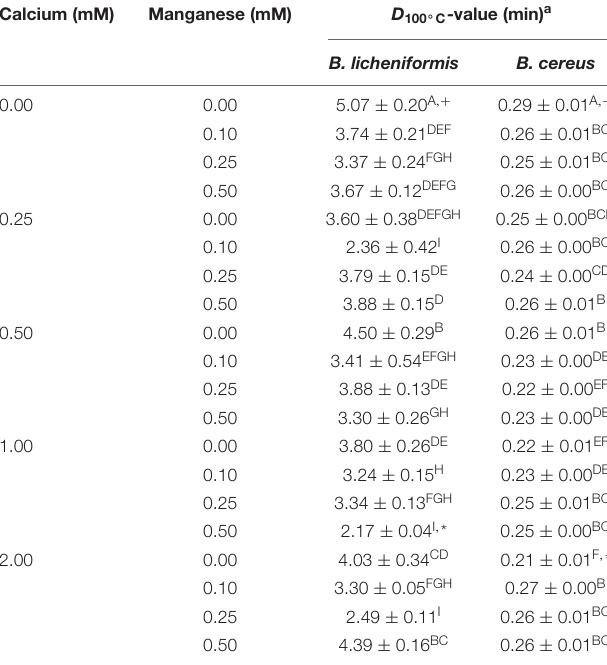
TABLE 1 | Statistical differences in heat resistance of B. licheniformis and B. cereus spores as affected by diverse concentrations of calcium and